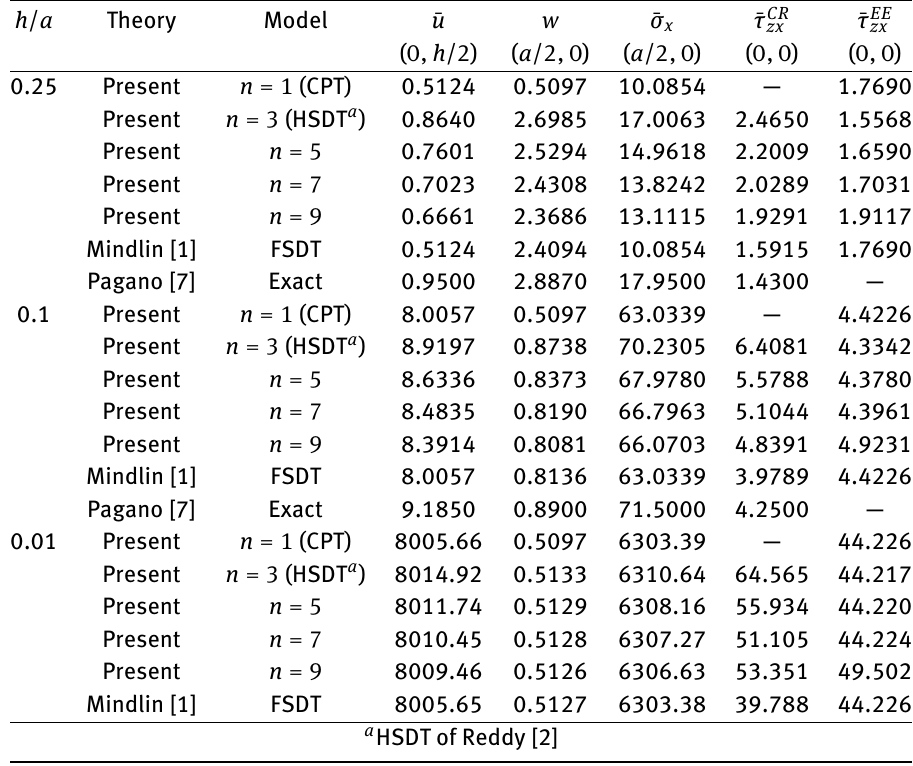
Table 3: Comparison of normalized displacements and stress for two layered (0 ∘ /90 ∘ /0 ∘ ) symmterically laminated composite plates in cylindrical bending (Material 1).